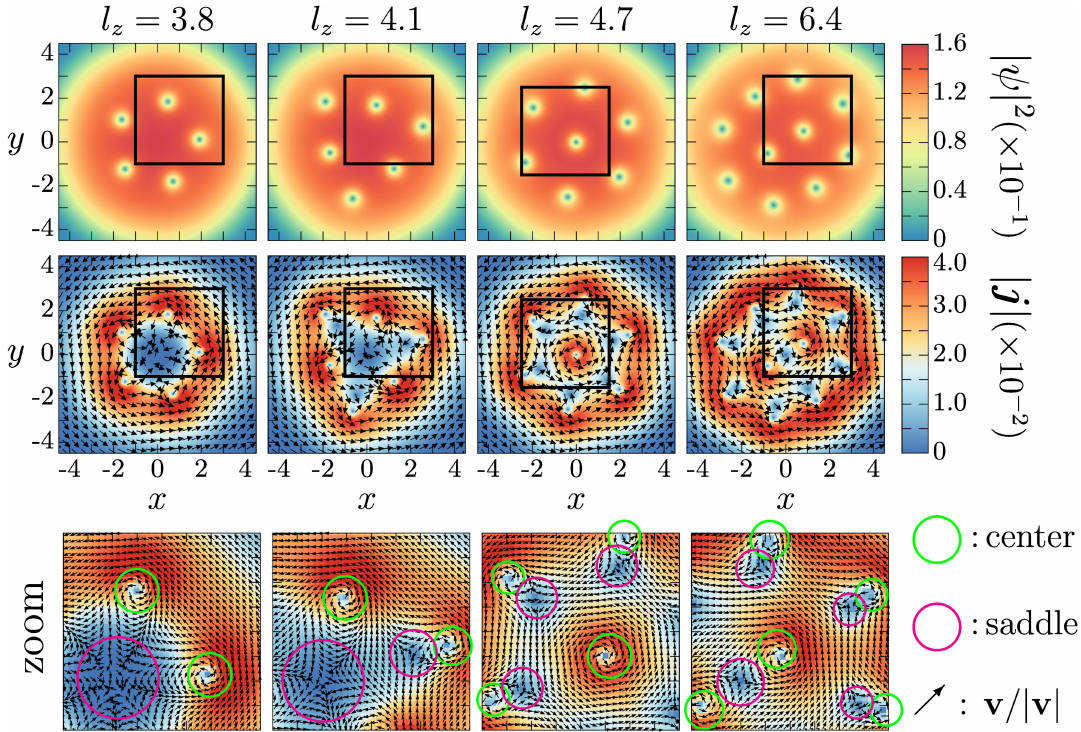
Figure 3 . The panels show the minimal energy configurations for larger values of the angular momentum L z = l z and N = 1 for the dimensionless coupling g = 400 . The displayed quantities are the same as in figure 2. According to the Poincaré index formula there are always one less stagnation points than there are vortex cores. The formation of paired vortex cores and stagnation points is in resemblance of the Kosterlitz-Thouless transition that occurs e.g. in the 2D XY model and the planar rotor